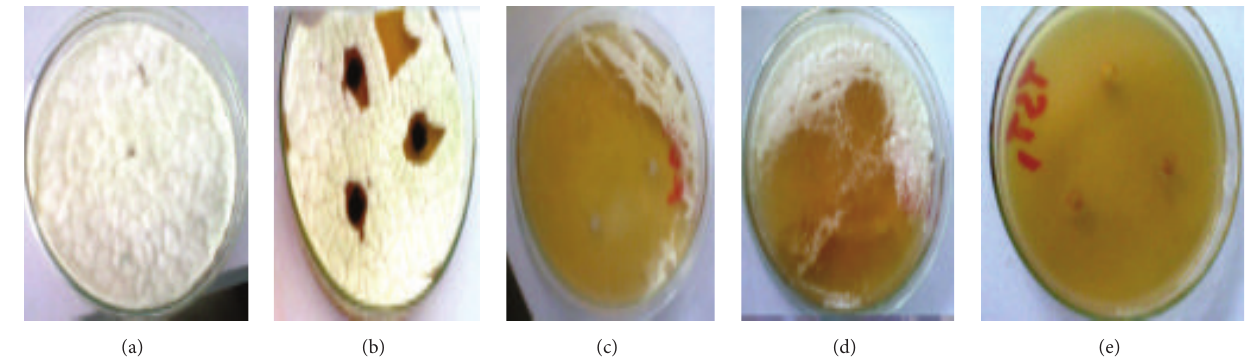
Figure 2: Growth inhibition zone on Trichophyton spp1 ((a) = DMSO, (b) = Matricaria chamomilla , (c) = Rosmarinus officinalis , (d) = Eucalyptus globulus , and (e) = Thymus schimperi ).